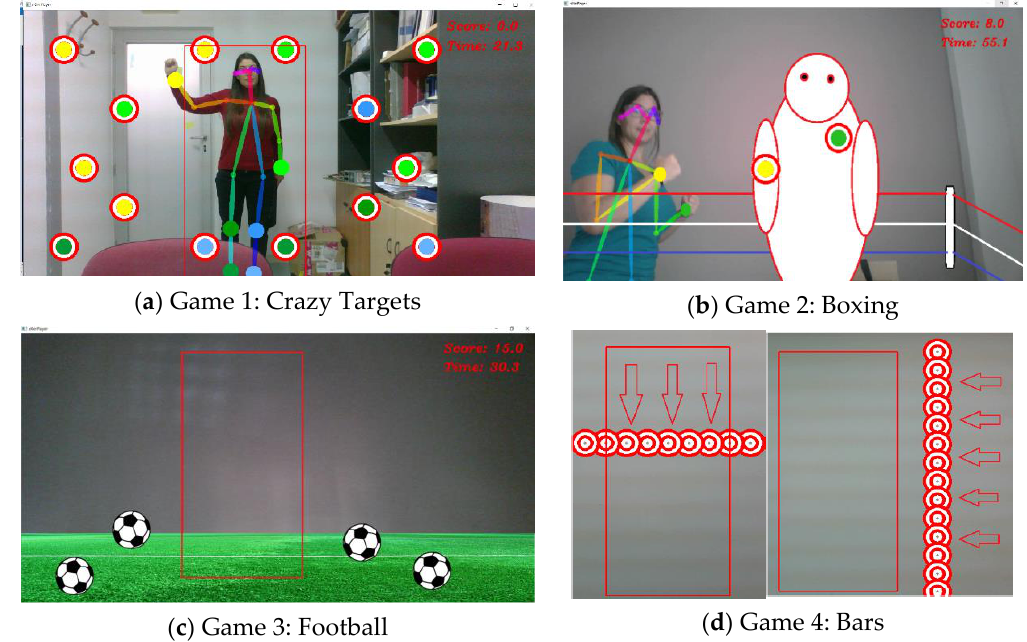
Figure 5. Different types of exergames developed.